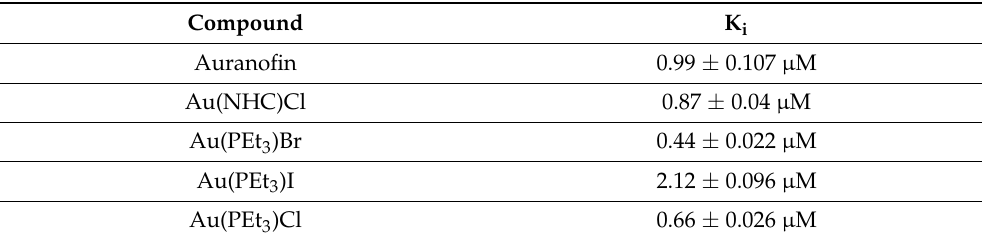
Table 1. Inhibition constants, K i values, measured for the interaction between gold compounds and M